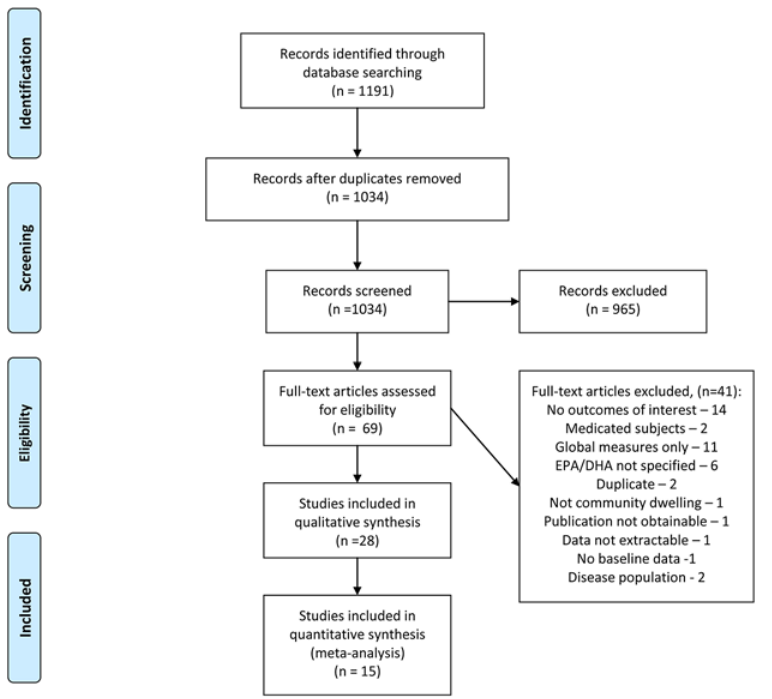
Fig 1. Flow Diagram of Study